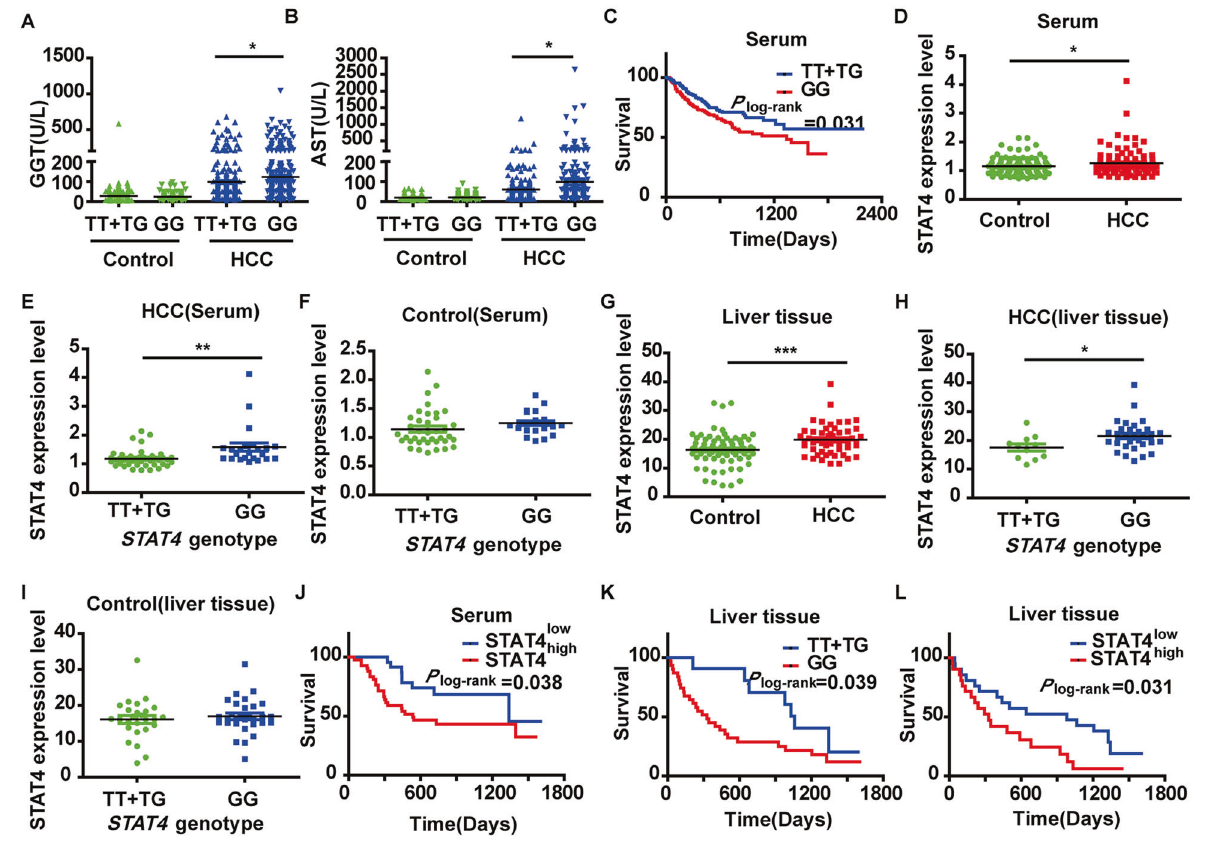
Fig. 1 Association of the stat4 rs7574865 genetic polymorphism with the risk of HCC. A , B The relationship between the stat4 genetic polymorphism and clinical parameters: GGT (Control: TT + TG N = 127, GG N = 159; HCC: TT + TG N = 230, GG N = 269) and AST (Control: TT + TG N = 127, GG N = 159; HCC: TT + TG N = 230, GG N = 269) (* P < 0.05 , P-value was calculated by Mann – Whitney U -test). C Kaplan – Meier survival curves for patients with HCC by stat4 genetic polymorphism (Serum: TT + TG N = 136, GG N = 178) P -values are depicted by Cox – Mantel log-rank test. D STAT4 expression in HCC patients and controls in human sera (Control: N = 60; HCC: N = 65). E , F STAT4 expression with different genotypes in human serum (HCC: TT + TG N = 42, GG N = 23 and Control: TT + TG N = 38, GG N = 22). G STAT4 expression in HCC patients and controls in human liver tissue (Control: N = 56; HCC: N = 42). H , I STAT4 expression with different genotypes in human liver tissue (HCC: TT + TG N = 13, GG N = 31; Control: TT + TG N = 25, GG N = 31) * P < 0.05, * P < 0.01, and *** P < 0.001 was assessed by Student ’ s t -test. J , L Survival curves of HCC patients with high and low STAT4 expression (Serum: N = 65; liver tissue: N = 42). K Kaplan – Meier survival curves for patients with HCC by stat4 genetic polymorphism (liver tissue: TT + TG N = 13, GG N = 31). P -values are depicted by Cox – Mantel log - rank test.